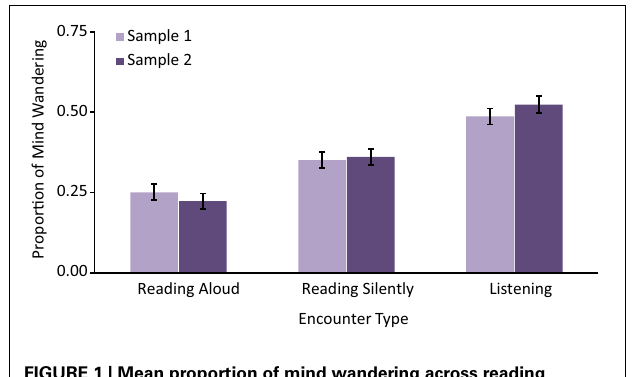
FIGURE 1 | Mean proportion of mind wandering across reading encounters. Error bars represent one standard error of the mean.